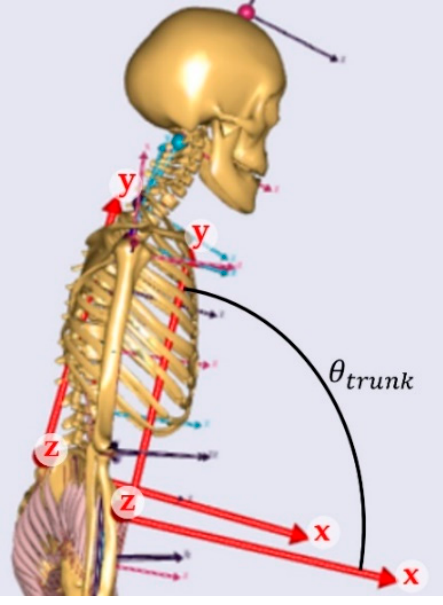
Figure 4. Definition of the trunk angle in the sagittal plane, which is the rotation around the z -axis between the anatomical frames of the pelvis and the thorax segments.